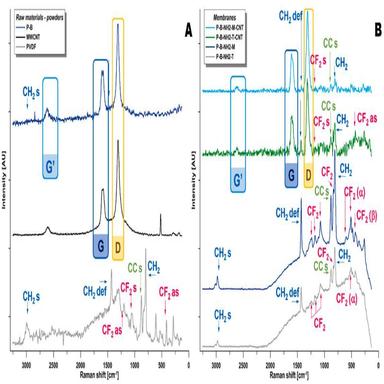
Raman spectra of powders (A) and membranes (B).